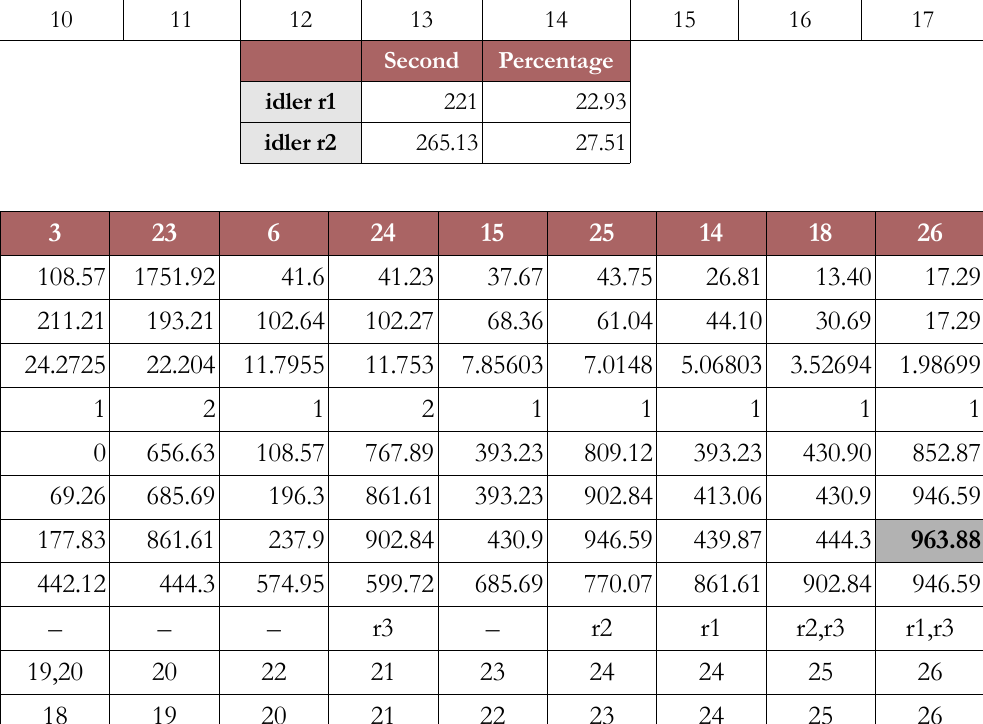
Table 11. ACTIM Scheduling, Rmax = 2, n(r) = 3 (Scenario